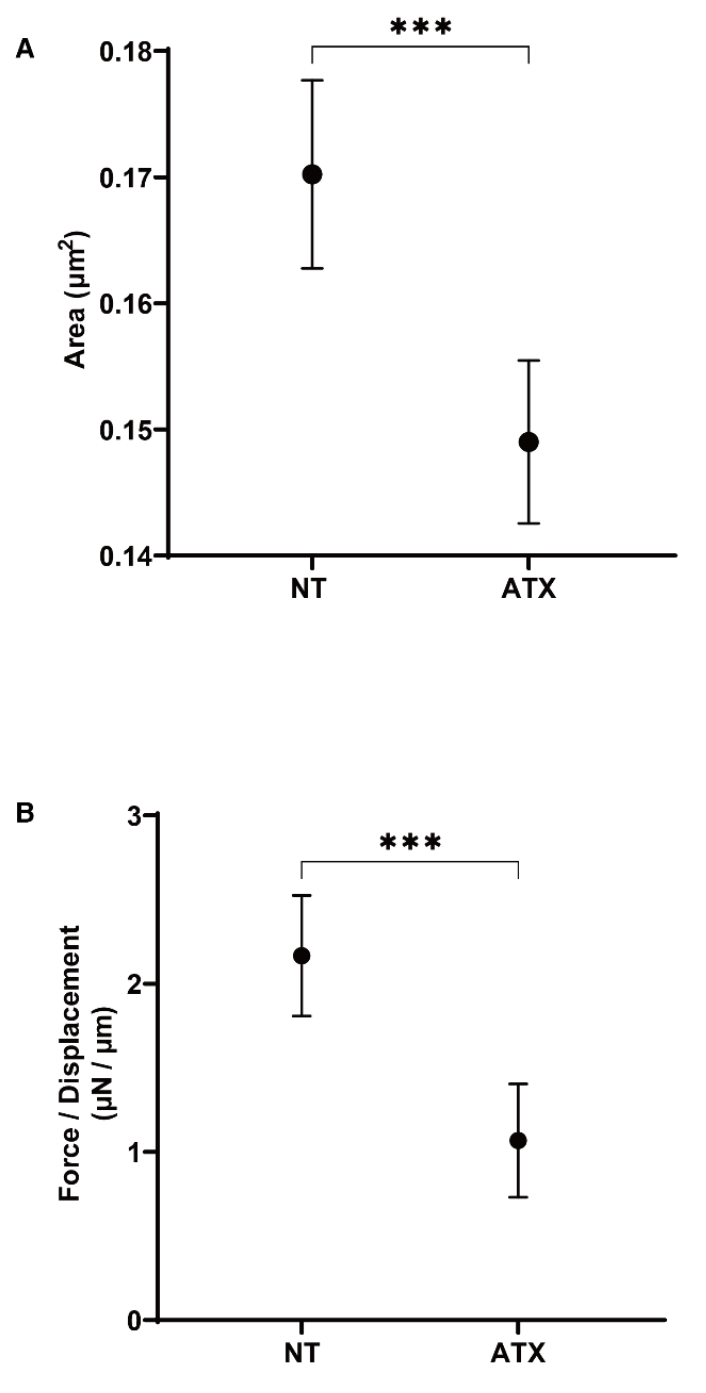
Figure 3. Effects of autotaxin (ATX) on the physical properties, size and stiffness of 3D HTM spheroid sizes. During the 6-day culture of the 3D HTM spheroids, they were exposed to a 2 mg/L solution of ATX during Day 5 through 6, and the mean sizes ( µ m 2 , panel ( A )) and stiffness ( µ N/ µ m, panel ( B )) of the HTM 3D spheroids were compared with non-treated control (NT). Data are presented as the arithmetic mean ± standard error of the mean (SEM). *** p < 0.005 (ANOVA followed by Tukey’s multiple comparison test).